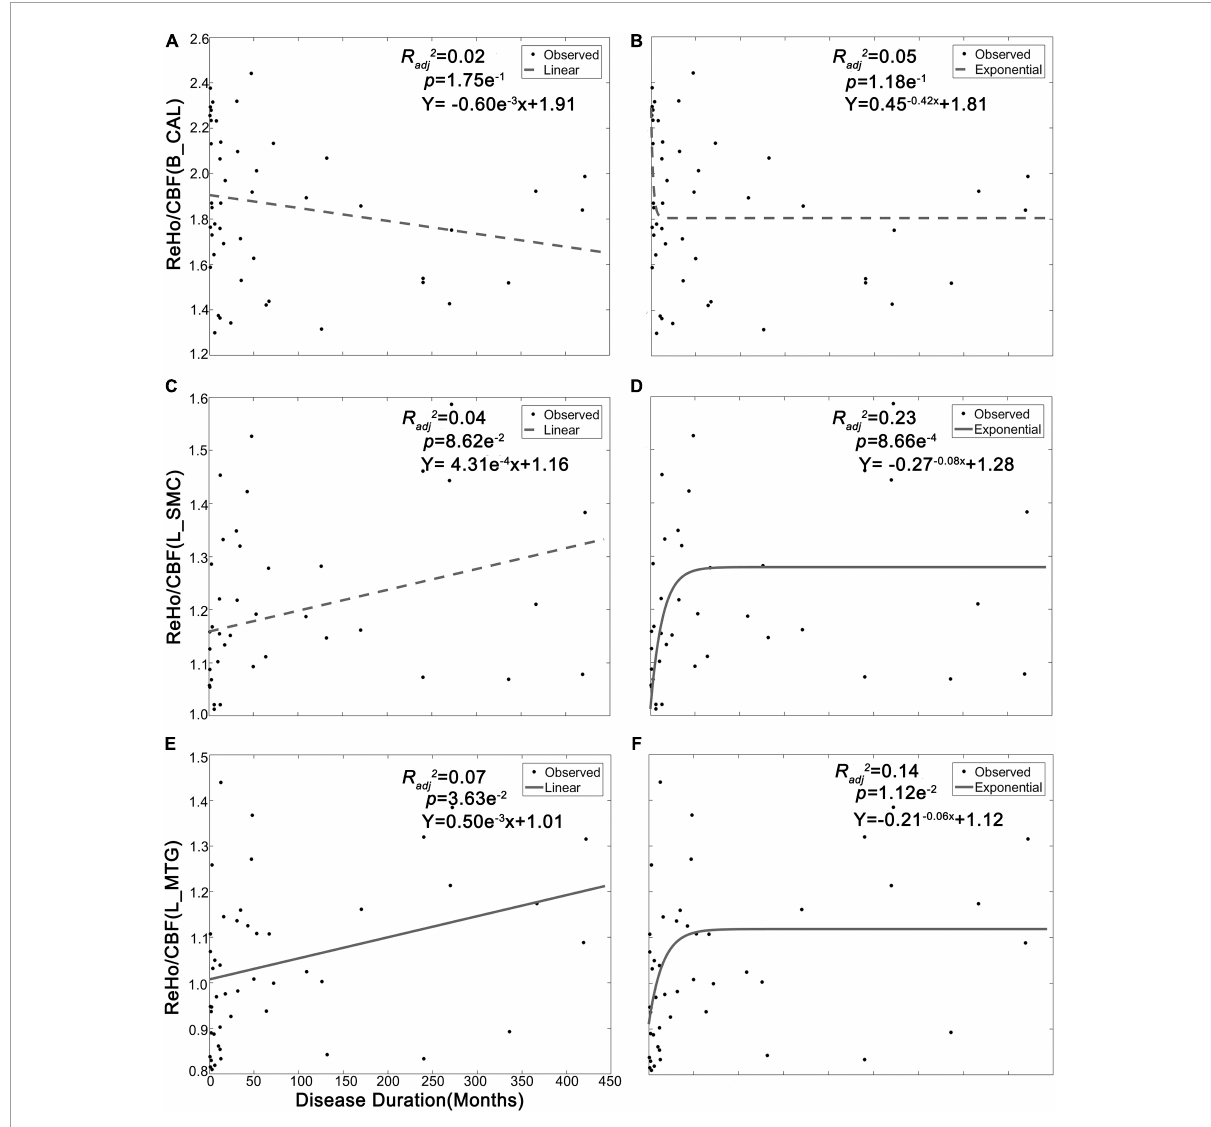
FIGURE3 Correlation between neurovascular coupling strength and disease duration of LHON. CBF, cerebral blood flow; ReHo, regional homogeneity; A-LHON, acute Leber’s hereditary optic neuropathy; C-LHON, chronic Leber’s hereditary optic neuropathy; B_CAL, bilateral calcarine fissure and surrounding cortex; L_MTG, left middle temporal gyrus; L_SMC, left sensorimotor